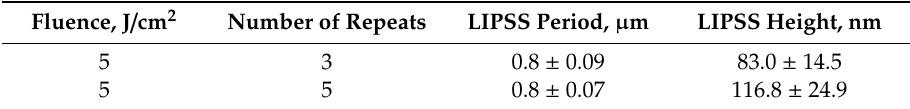
Table 5. Period and height of LIPSS per fluence.